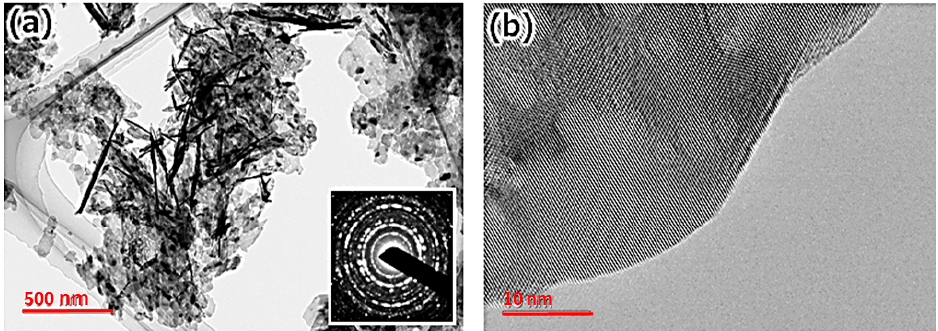
Figure 4. ( a ) Bright field (BF) and ( b ) high-resolution (HR) TEM images of the as-received Y 2 O 3 powder. Selected area diffraction (SAD) pattern taken from the general area was inserted in ( a ).